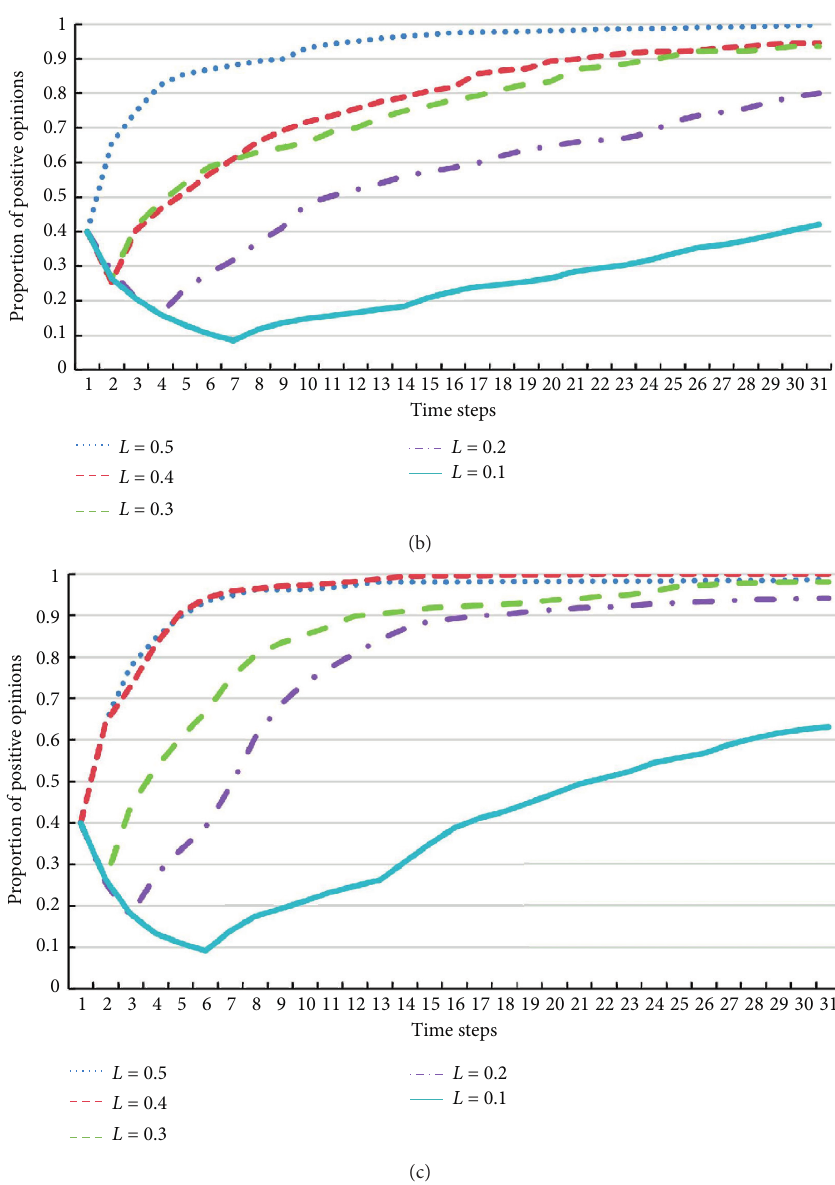
Figure 6: The evolution trends for the initial proportion pp � 0 . 4, opinion control levels k � 1 , 3 , and 5, and L � 0 . 5 , 0 . 4 , 0 . 3 , 0 . 2 , and 0 . 1 in � 20 and m � 5. (a) The initial proportion pp � 0.4, C � 2, and L � 0.5, 0.4, 0.3, 0.2, and 0.1. (b) The initial scale-free networks with m 0 proportion pp � 0.4, C � 6, and L � 0.5, 0.4, 0.3, 0.2, and 0.1. (c) The initial proportion pp � 0.4, C � 10, and L � 0.5, 0.4, 0.3, 0.2, and